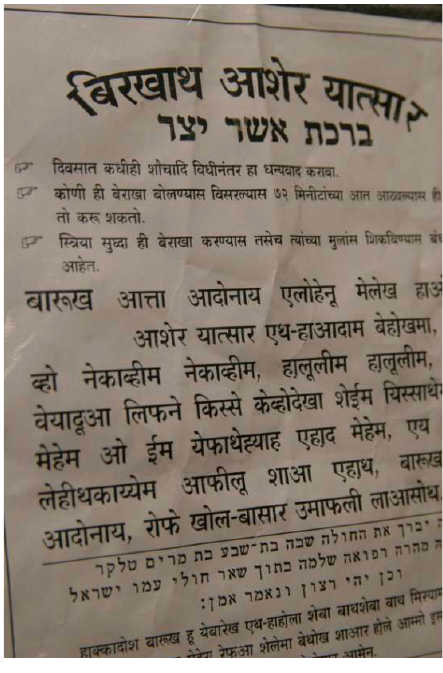
Figure 5. Prayer board at the Magen HaShalom synagogue, Ramle (photo: the author, 2006).